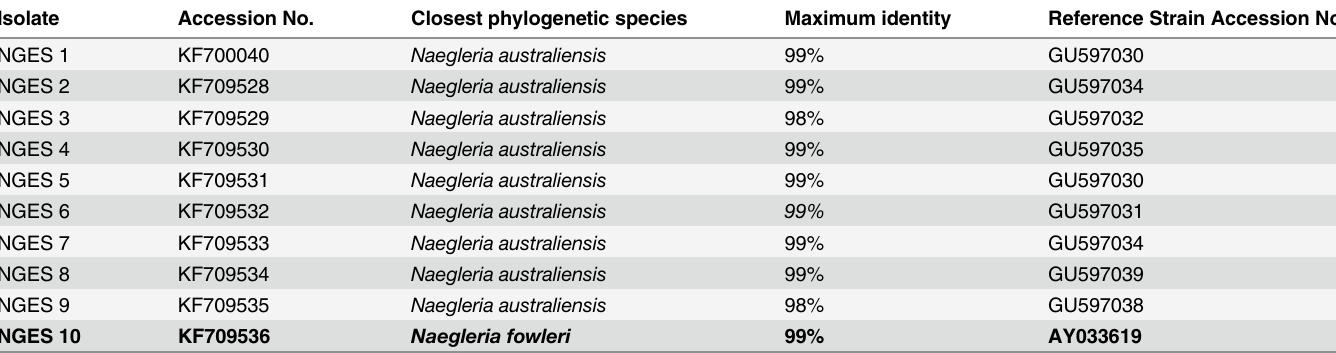
Table 2. Result of DNA sequencing of the selected amplicons (NGES1-NGES10). Isolate